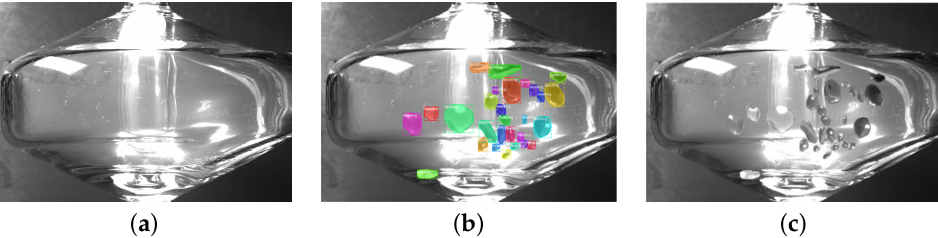
Figure 6. Cut-Paste data synthesis using clean spray-chamber ( a ) and beading instances from an (un-pictured) image coloured in ( b ). The resulting synthetic images in ( c ) are then added to the training